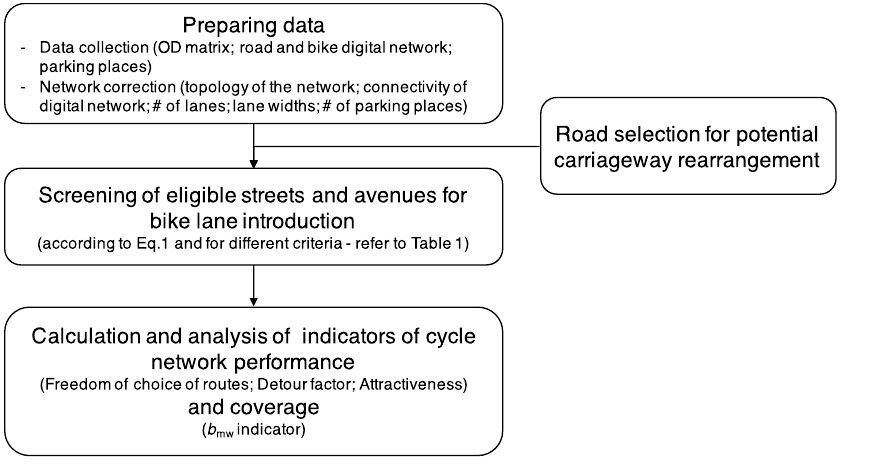
Figure 3. Methodological